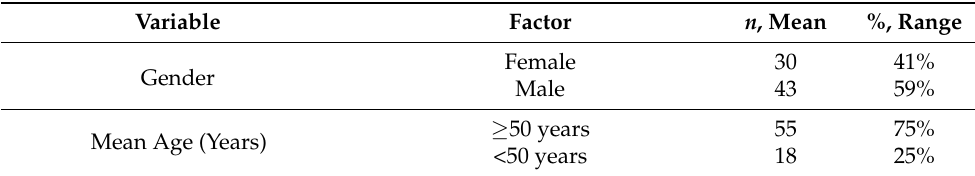
Table 1. Patient Demographics and Tumor